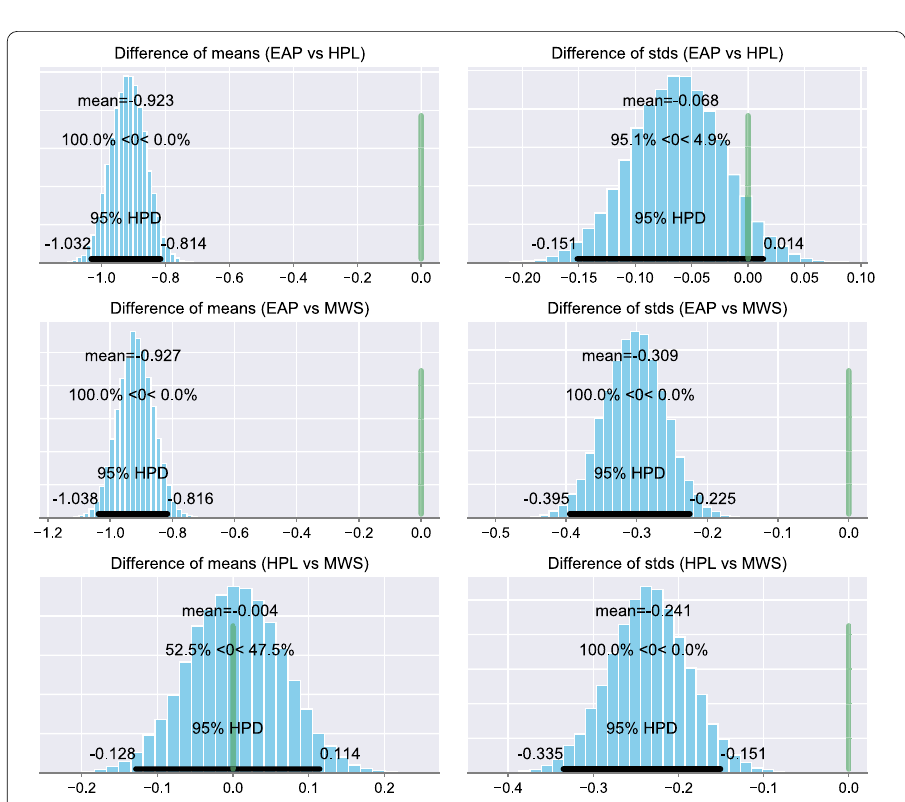
Figure 19 Posterior distributions and 95% credible intervals of differences for exemplary Fourier coefficient feature. Left column: difference of means. Right column: difference of standard deviations. Top row: EAP vs HPL. Middle row: EAP vs MWS. Lower row: HPL vs MWS. The 95% credible intervals are shown as a black horizontal